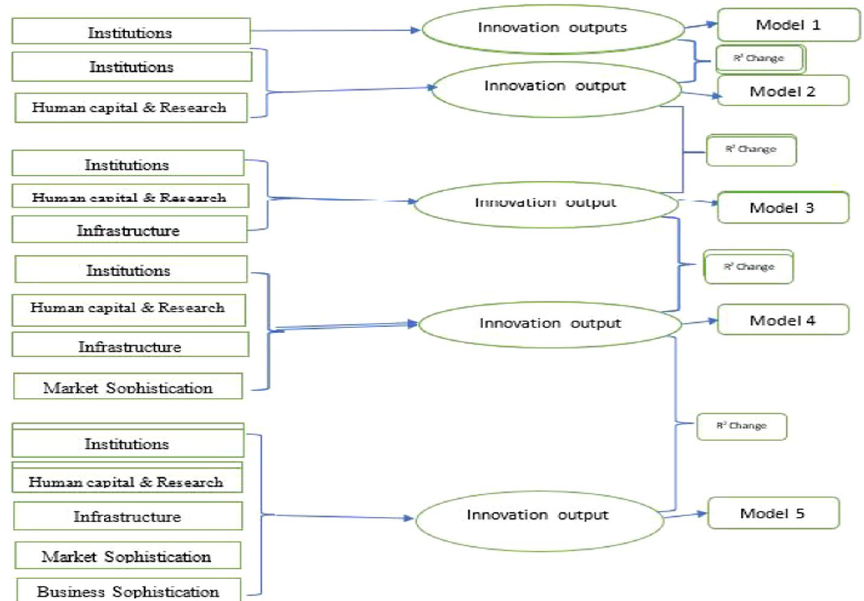
Fig. 1 The prototype of the hierarchical multiple regression models (Source: Authors’ work,